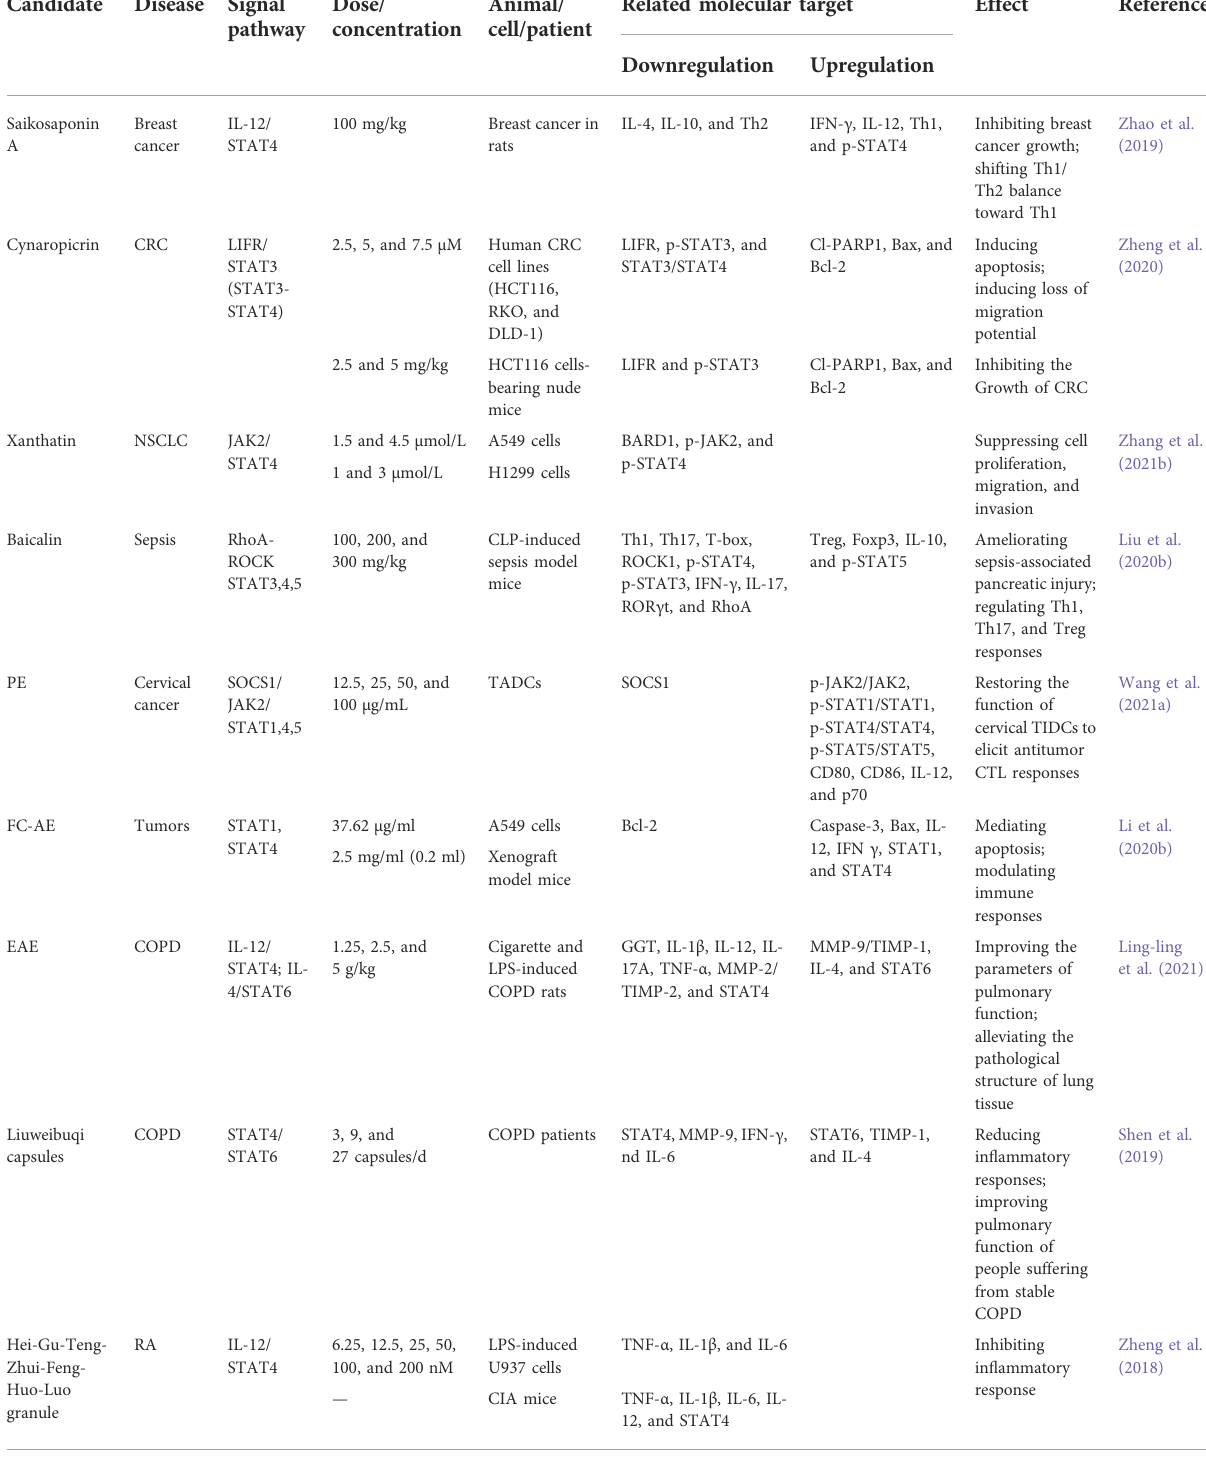
TABLE 4 Chinese herbs and herb formulas, natural compounds, and phytochemicals in the treatment of diseases through mediating